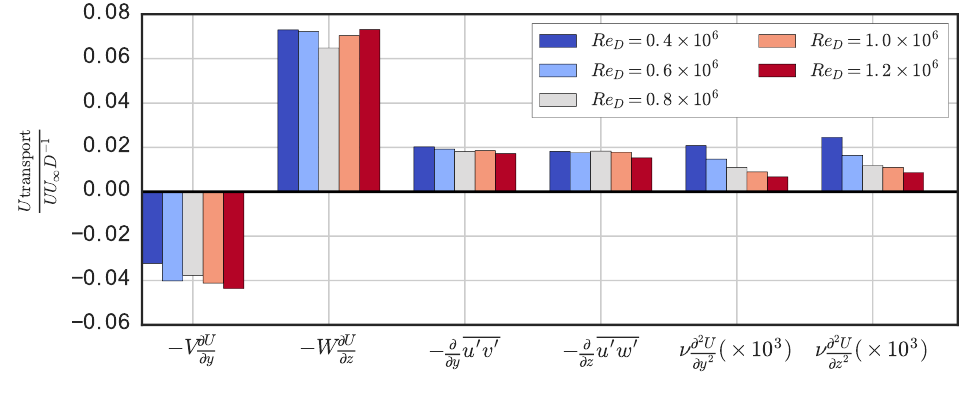
Figure 14. Normalized streamwise momentum transport quantities computed as weighted averages from Equation (8).